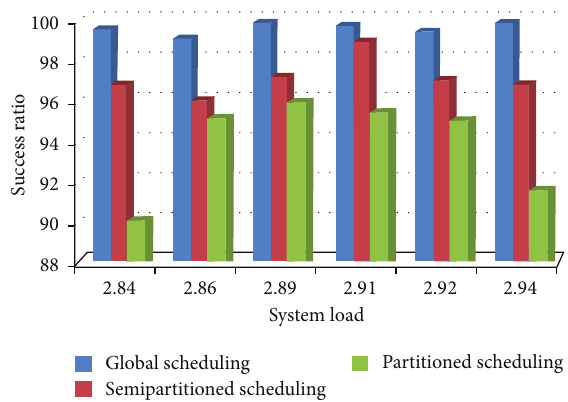
Figure 10: Comparison of success ratio for different scheduling